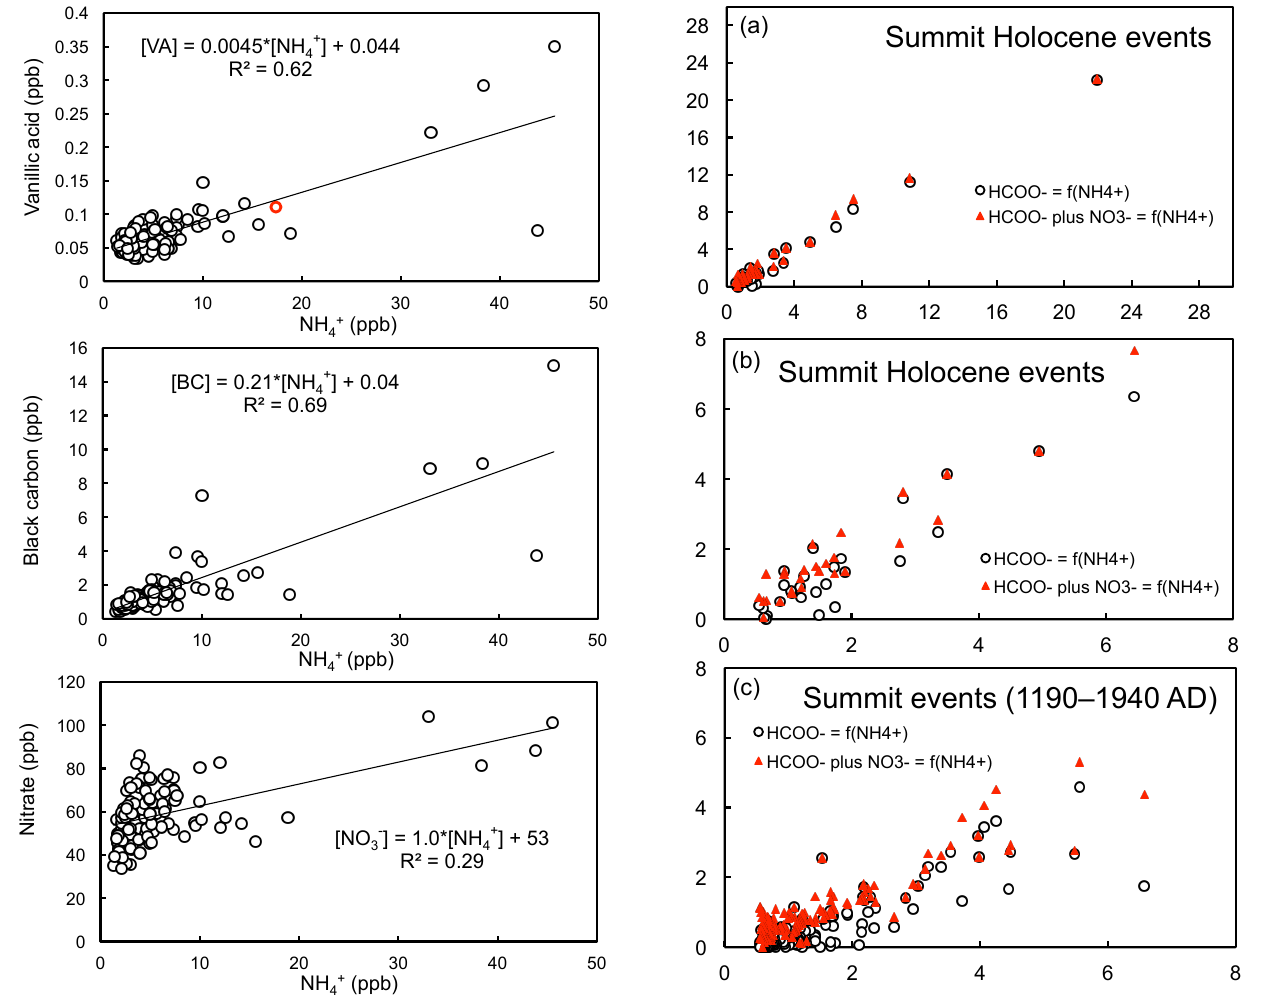
Figure 6. Annual mean concentrations of vanillic acid, BC, and nitrate vs. ammonium in snow layers deposited at D4 during pre- industrial times (from 1740 to 1870). For vanillic acid, we also re- port the point corresponding to the 1908 event (red circle).